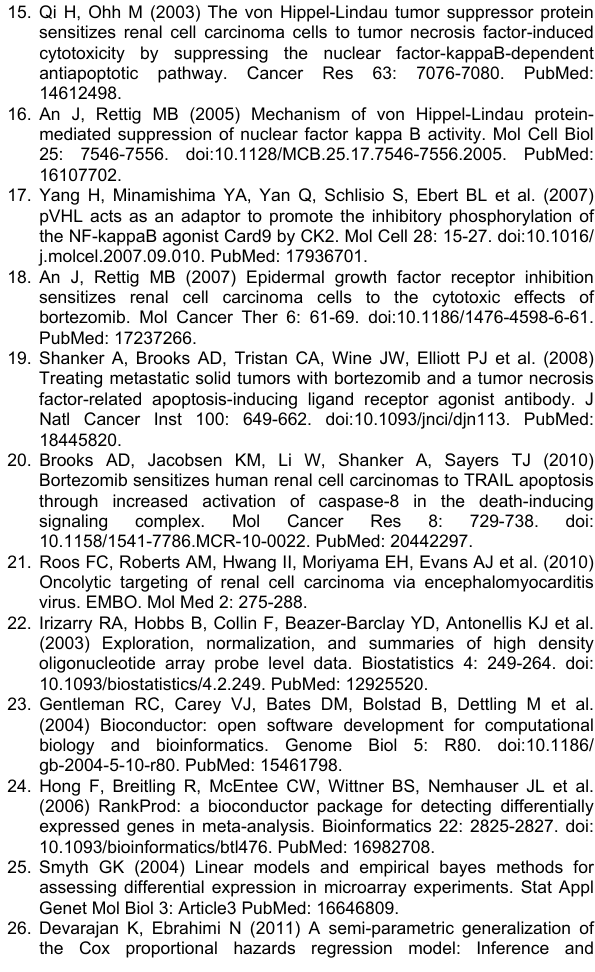
Table S2. List of NF-κB target genes used for meta- analysis.